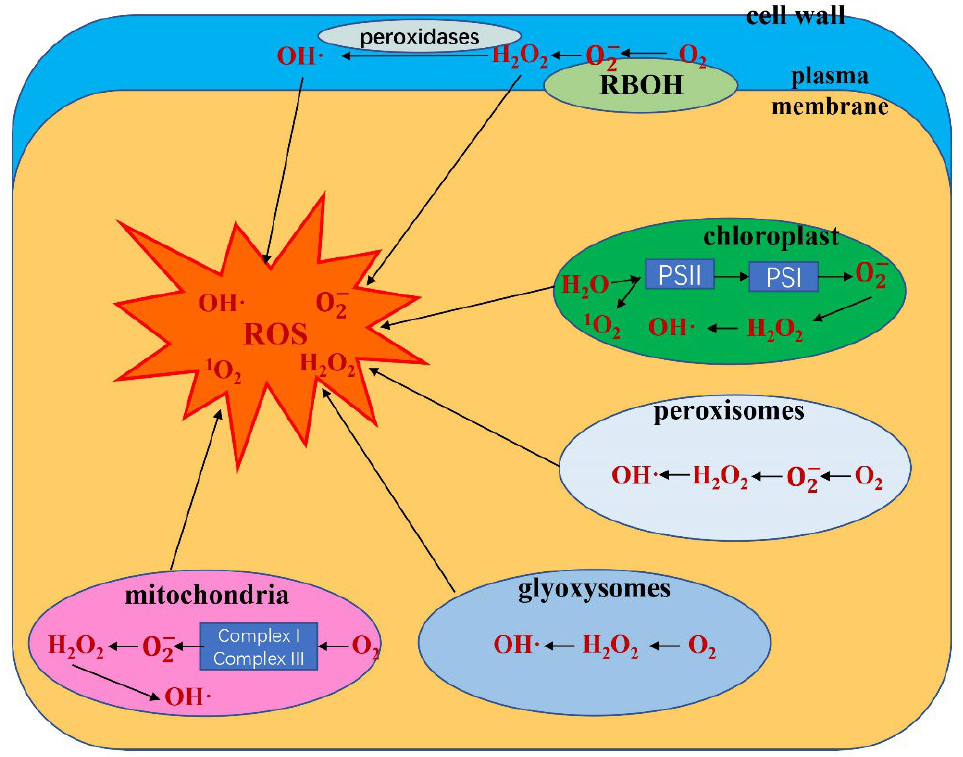
Figure 2. Model of the production and metabolic fate of various ROS (OH · , 1 O 2 , H 2 O 2 , O − different cellular compartments (chloroplasts, mitochondria, peroxisomes, glyoxysomes, plasma membrane and apoplast).